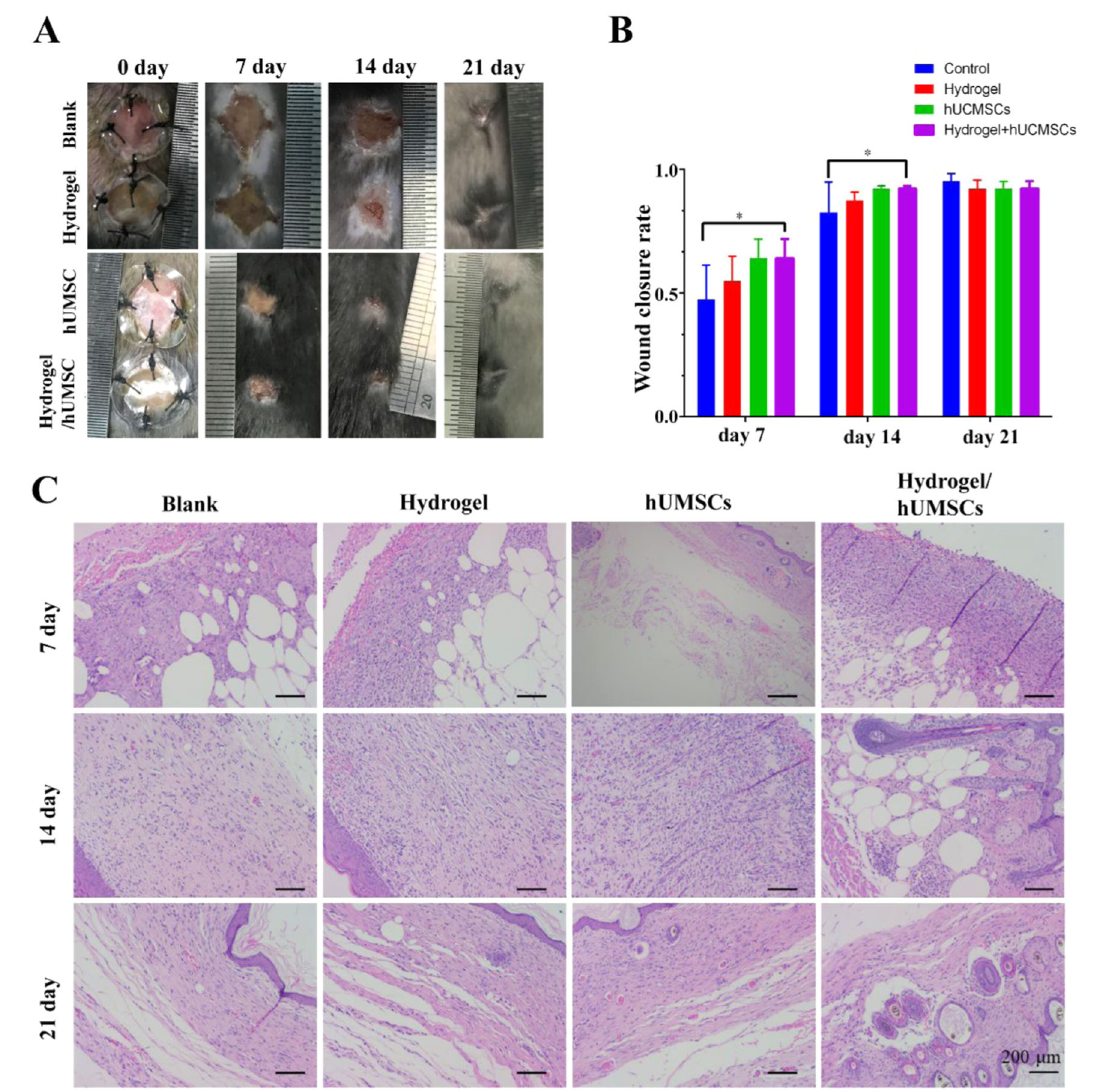
Fig. 5 Hydrogel-hUMSCs combined treatment accelerates wound closure in diabetic mice. A Representative images of wounds during 21-day in vivo experiments. B Quanti fi cation of wound closure rate